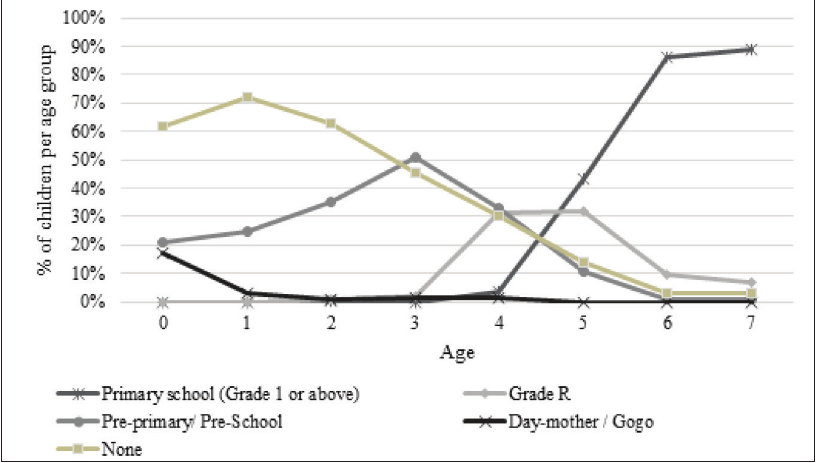
Figure 2: Preschool choices in 2012 (Source: SALDRU 2008; 2010-2011; 2012). Notes: ‘Age’ is the age of the child on 1 January